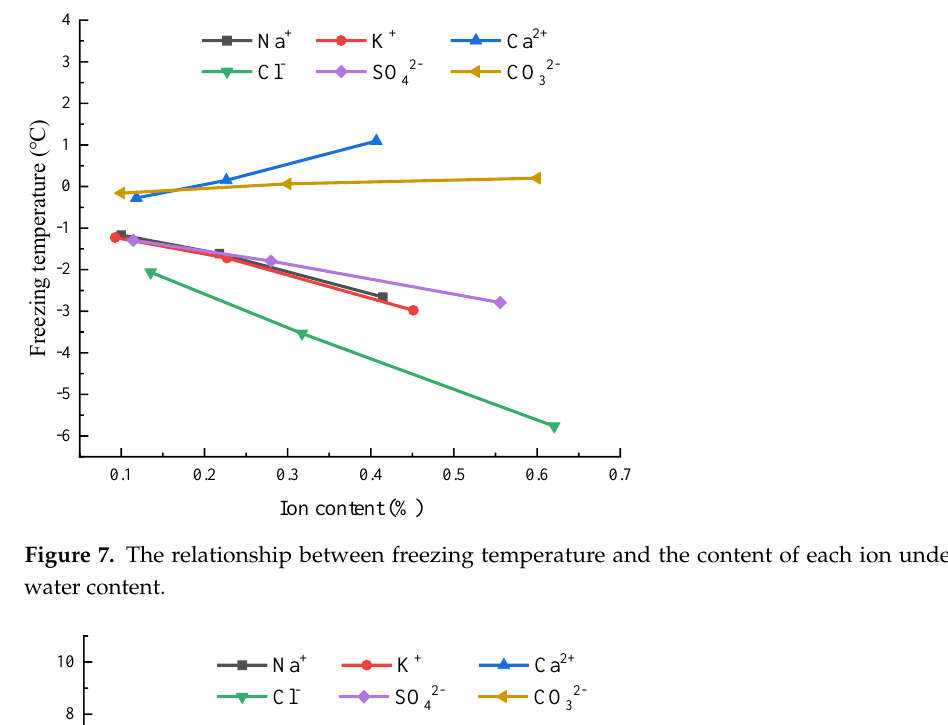
Figure 7. The relationship between freezing temperature and the content of each ion under 10% water content.